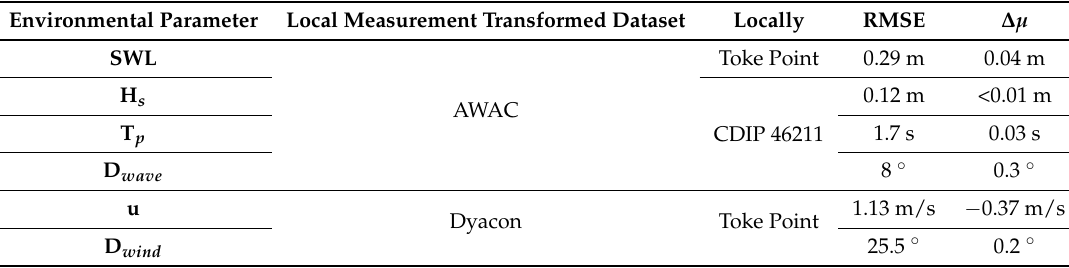
Table 1. Root mean squared error (RMSE) and bias ( ∆ µ ) of transformed oceanographic and meteorological measurements, used to drive Windsurf boundary conditions, compared to local measurements. The local marine measurements used for comparison are 42 days and are 291 days for the wind